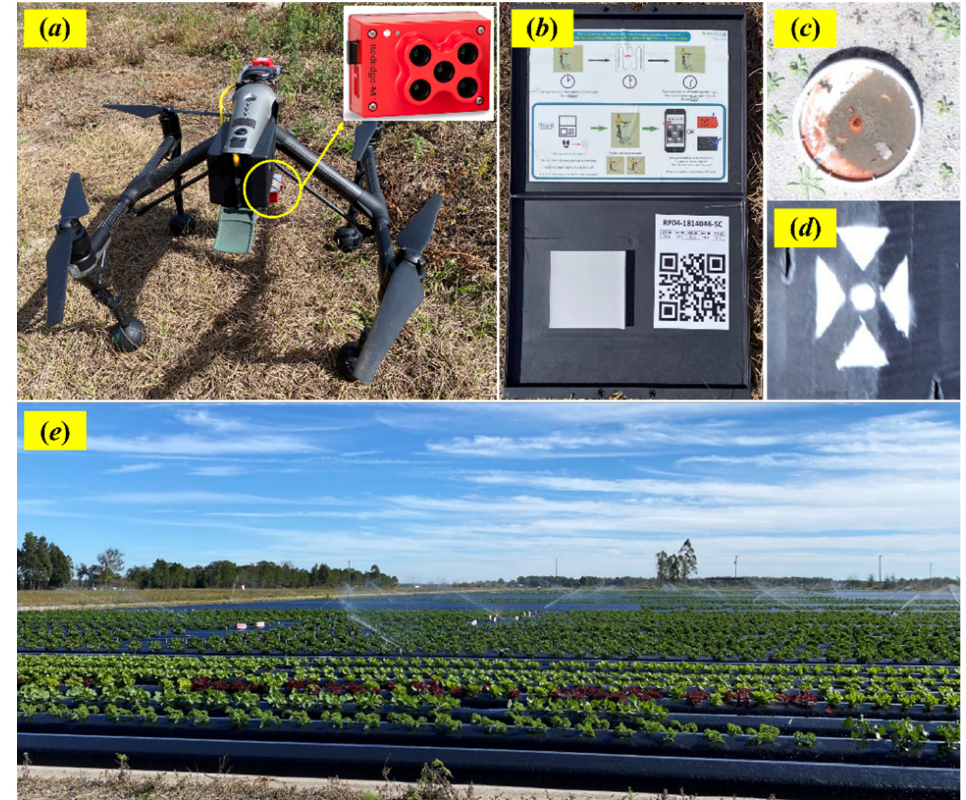
Figure 2. UAV systems and GCP setup: ( a ) the Inspire 2 platform equipped with a MicaSense RedEdge-M multispectral camera; ( b ) the calibration reflectance panel (CRP); ( c ) GCPs around the strawberry beds (M1–M8); ( d ) GCPs on the plastic beds (N1–N16); ( e ) strawberry farm.